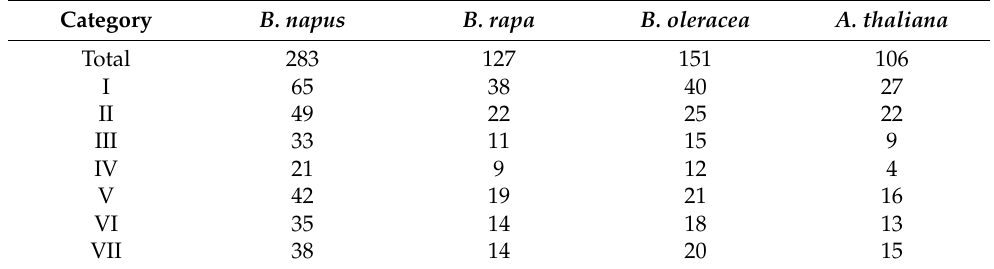
Table 1. The total number of nsLTP genes in each group of B. napus , B. rapa , B. oleracea and A. thaliana . Category B. napus B.